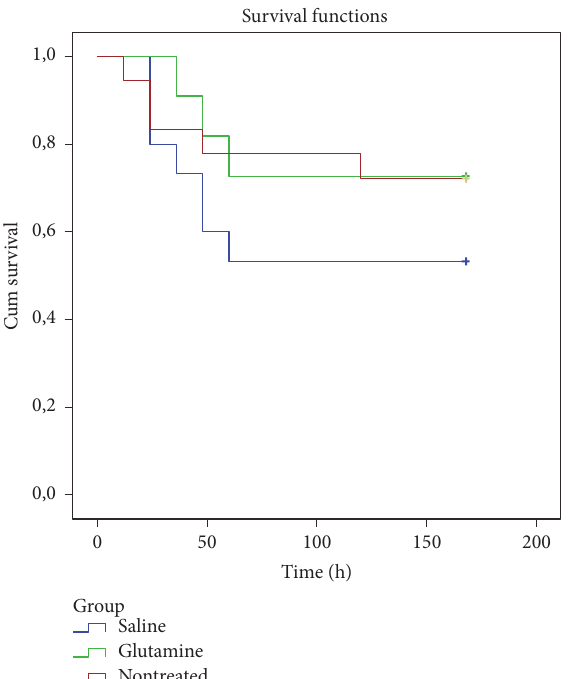
Figure 3: Seven-day mortality rates of Lewis rats treated or not treated with 48 h parenteral infusion of saline or glutamine before acute pancreatitis induction with sodium